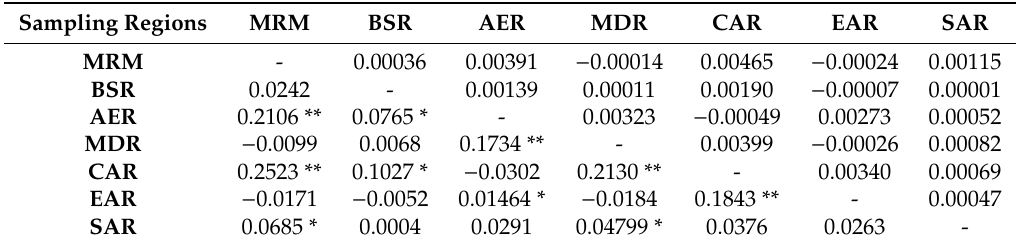
Table 4. Matrix of pairwise F ST (below diagonal) and D A (D-loop nucleotides sequence divergence, above diagonal) distances between 16 Turkish indigenous donkey